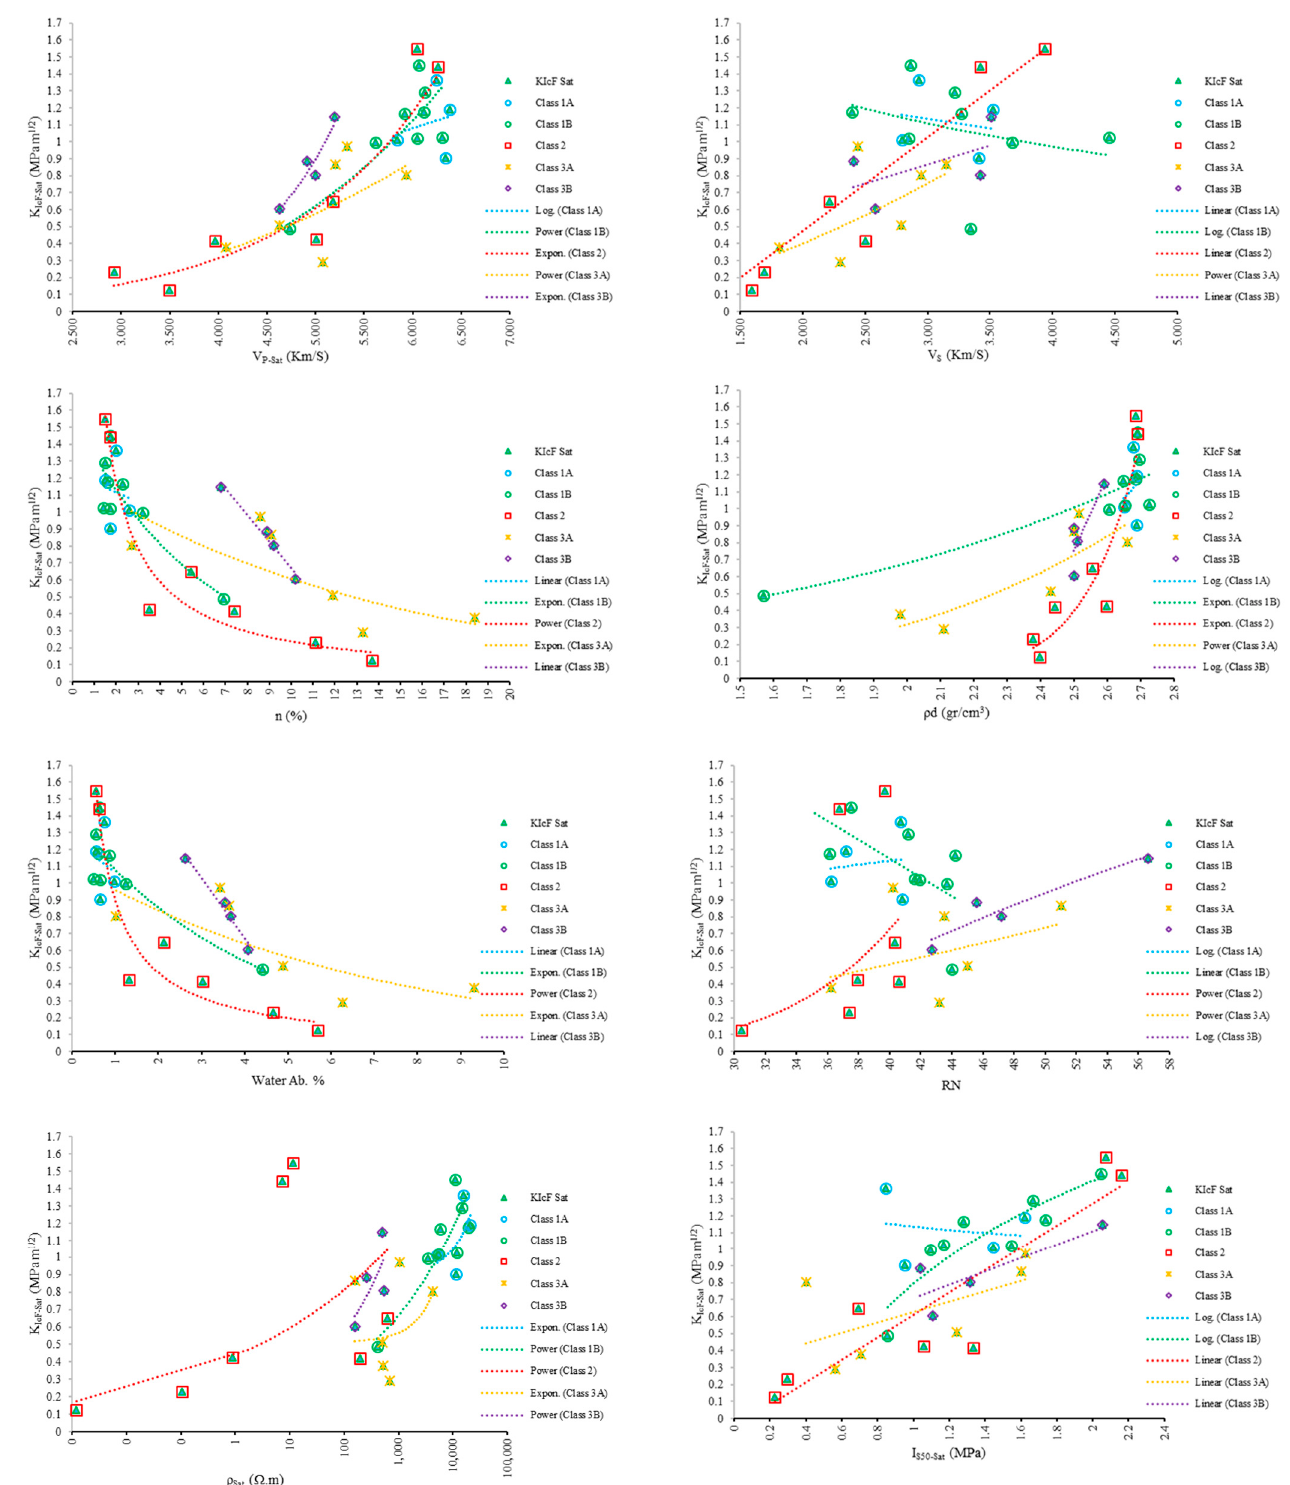
Figure 11. K IC versus different engineering properties for each petrographic class under a saturated